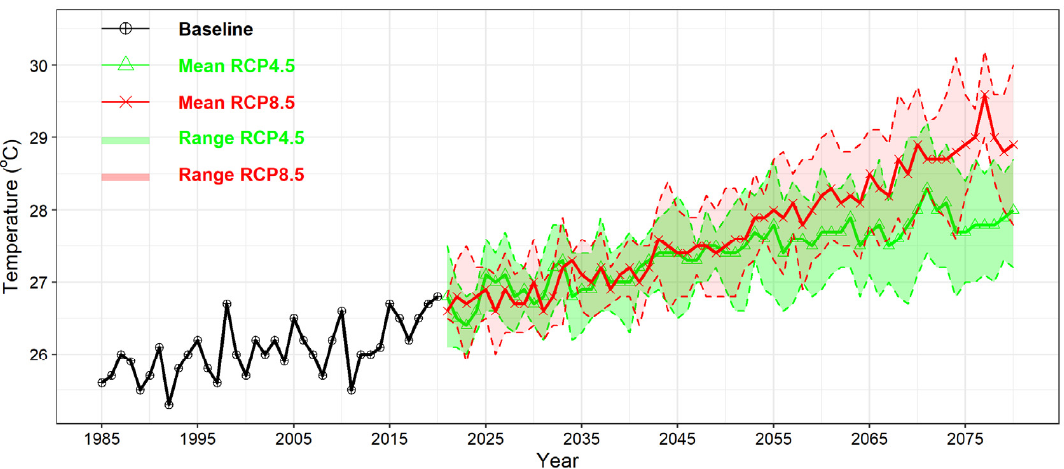
Figure 7. Baseline and projected mean annual temperature for RCP4.5 and RCP8.5 scenarios in the SRB.